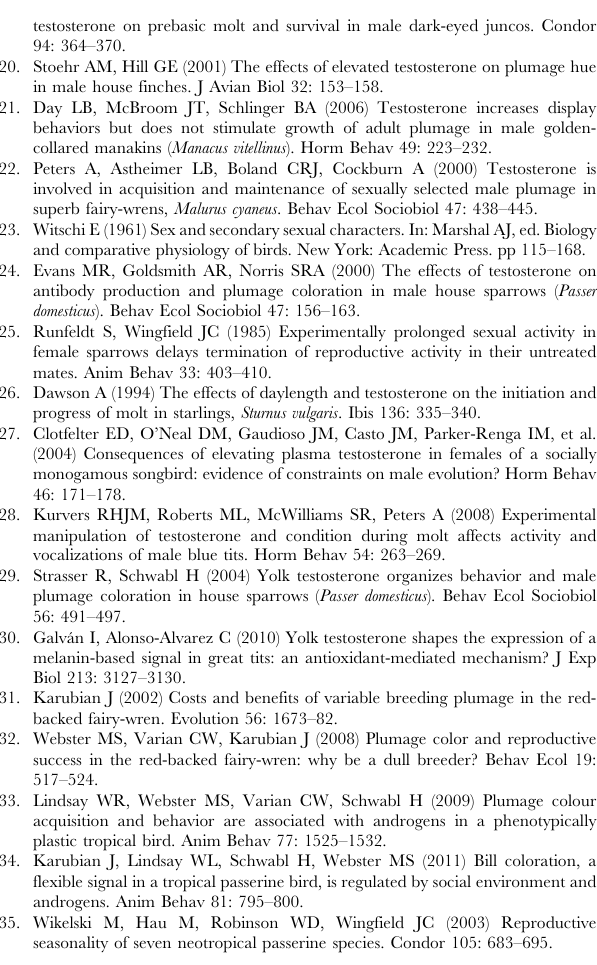
Table S1 Variation between testosterone, anti-testos- terone and after-second-year males in reflectance of back, breast and crown